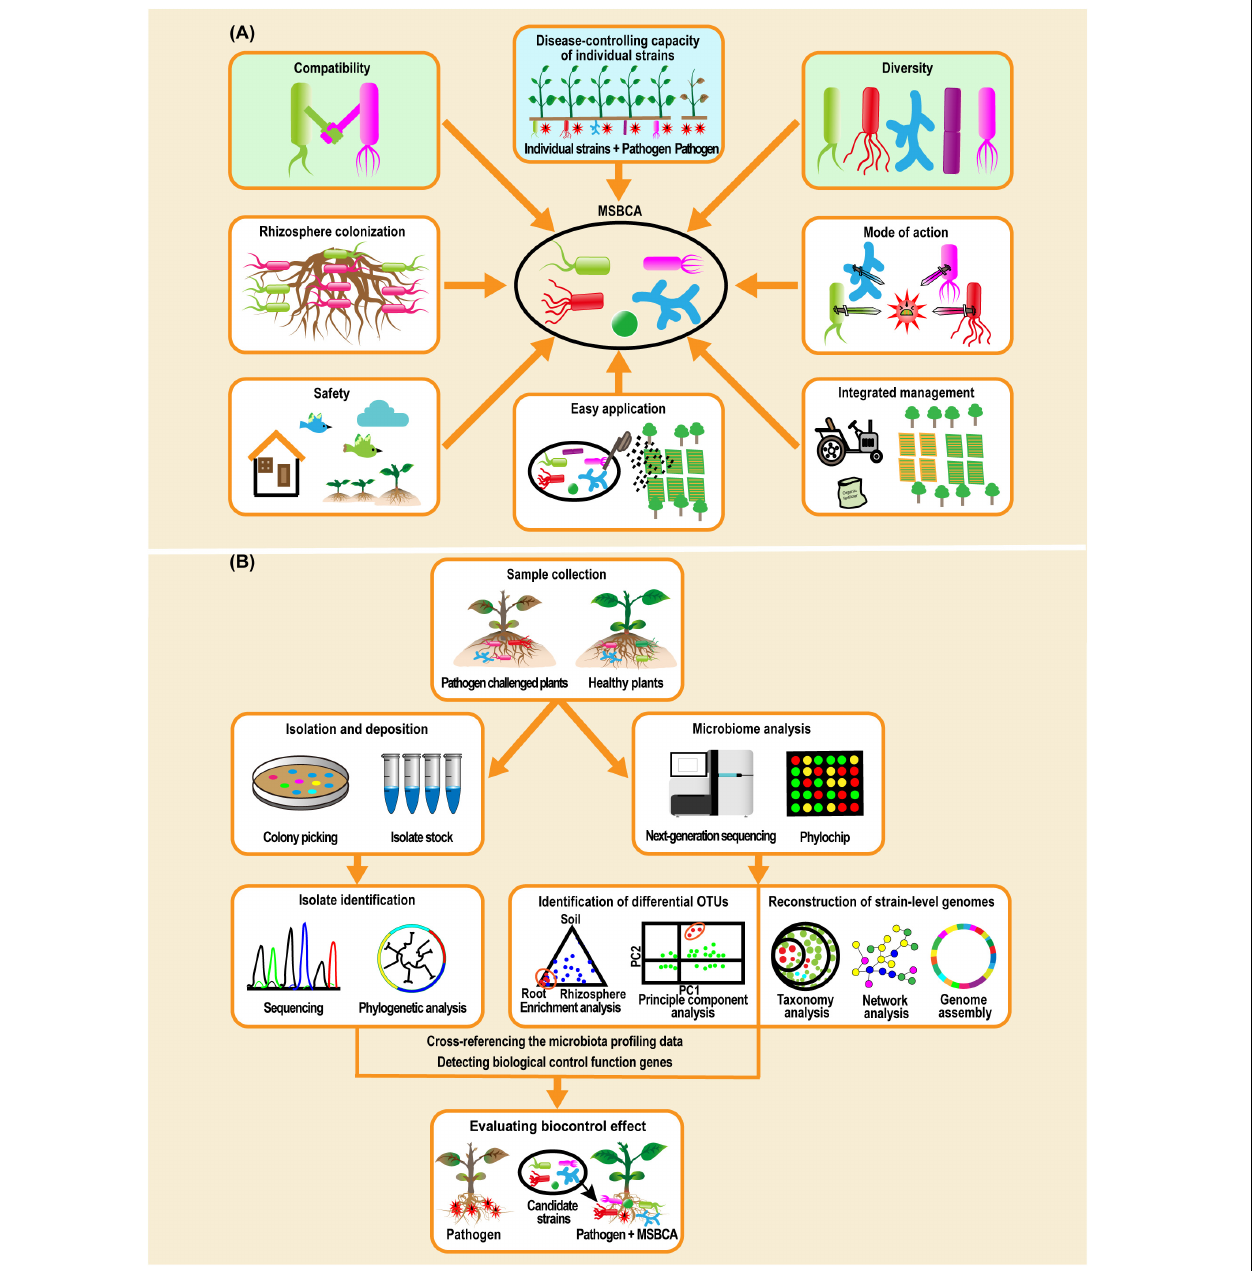
FIGURE 2 | Biological features need to be considered when constructing multiple-strain biological control agents (MSBCAs) and workflow of assembling MSBCAs using a reductionist synthetic community (Vorholt et al., 2017; Liu et al., 2019). (A) Biological features involving disease-suppressive effects of each individual strain, compatibility, diversity, microbial colonization of rhizosphere, mode of action for disease control, safety to humans and the environment, easy application and convenience to be incorporated into an existing management system (Raupach and Kloepper, 1998; Sikora et al., 2010; Bashan et al., 2013; Grosskopf and Soyer, 2014; Ahkami et al., 2017), need to be taken into account when establishing the MSBCAs for soil-borne diseases. (B) In general, methodology of constructing MSBCAs by a reductionist synthetic community approach is built on the conception of host-mediated selection of plant-associated microbiota (Mueller and Sachs, 2015). Microbiome analysis by 16S rRNA gene amplicon sequencing or metagenomics sequencing, or by PhyloChip analysis, in parallel to the extended microbial strain isolation to achieve as much diversity as possible, is an early step to pick the potential disease-suppressing species by identifying the differential OTUs between the microbiome of the samples collected from pathogen challenged and control plants (Berendsen et al., 2018), or by reconstructing strain-level genomes based on functional diversity (Carrión et al., 2019). Then, after cross-referencing the microbiota profiling data with the taxonomic identities of the isolates in comprehensive culture collections (Niu et al., 2017; Berendsen et al., 2018), or by detecting the genes encoding the functions of biological control in the genomes of cultivated isolates (Carrión et al., 2019), the candidate strains will be characterized and selected for the multi-strain community, of which the disease-reducing effects will be further